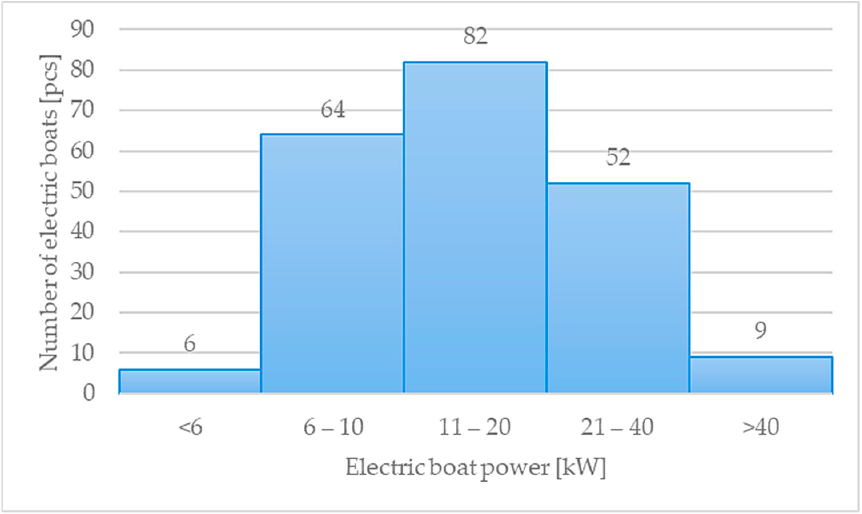
Figure 7. The distribution of the small electric boats in the sailing marinas of Lake Balaton by the power of their electric motors, own results.